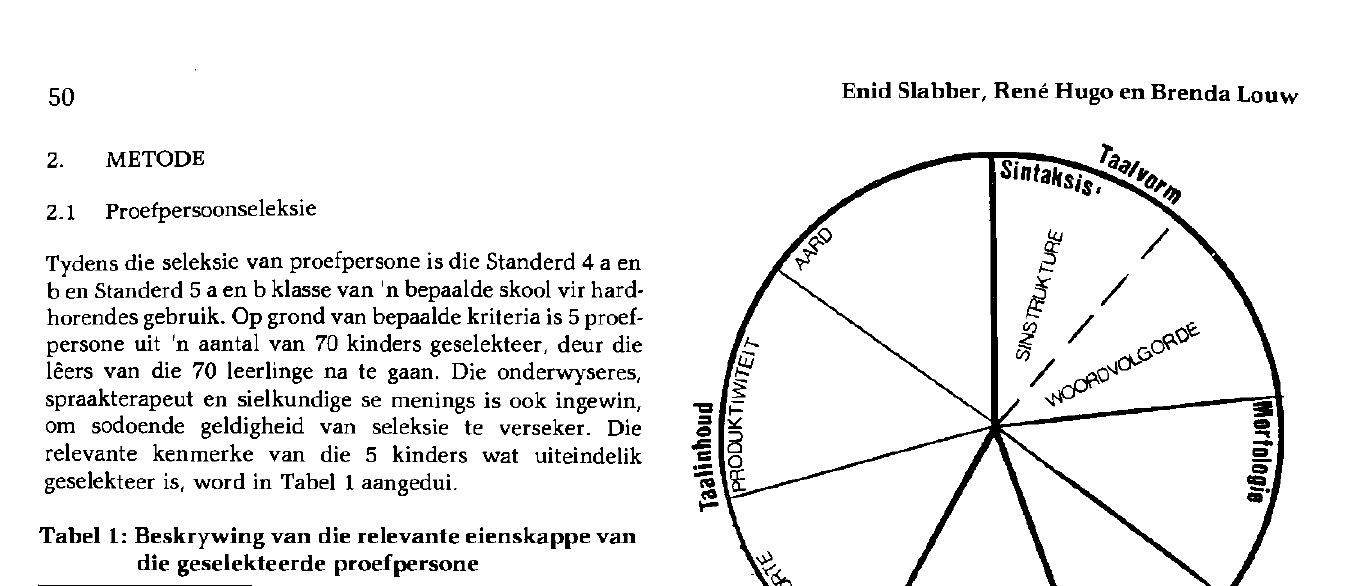
Kriteria vir seleksie Proefpersoonnommer